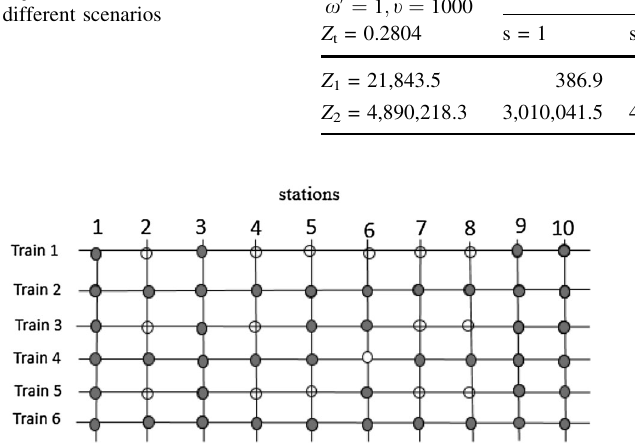
Fig. 4 The skip-stop schedule obtained for the robust optimization model